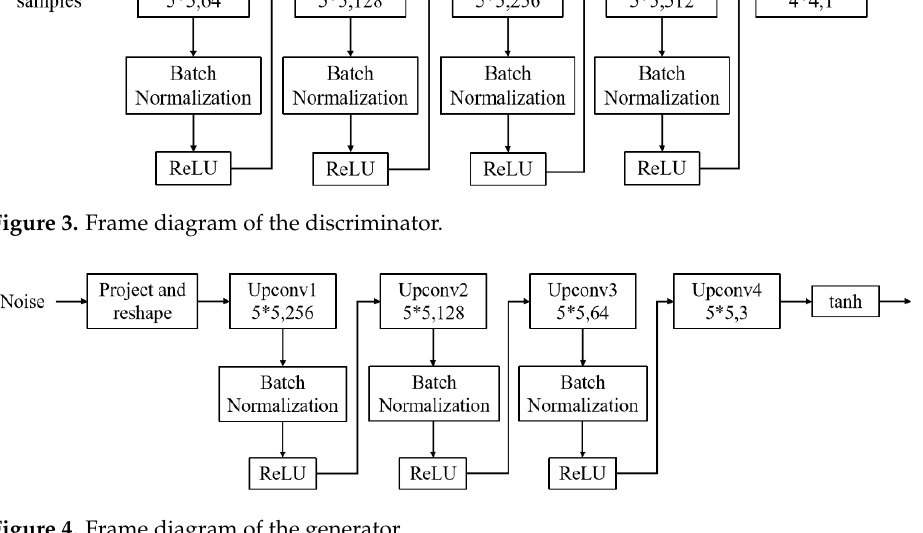
Figure 4. Frame diagram of the